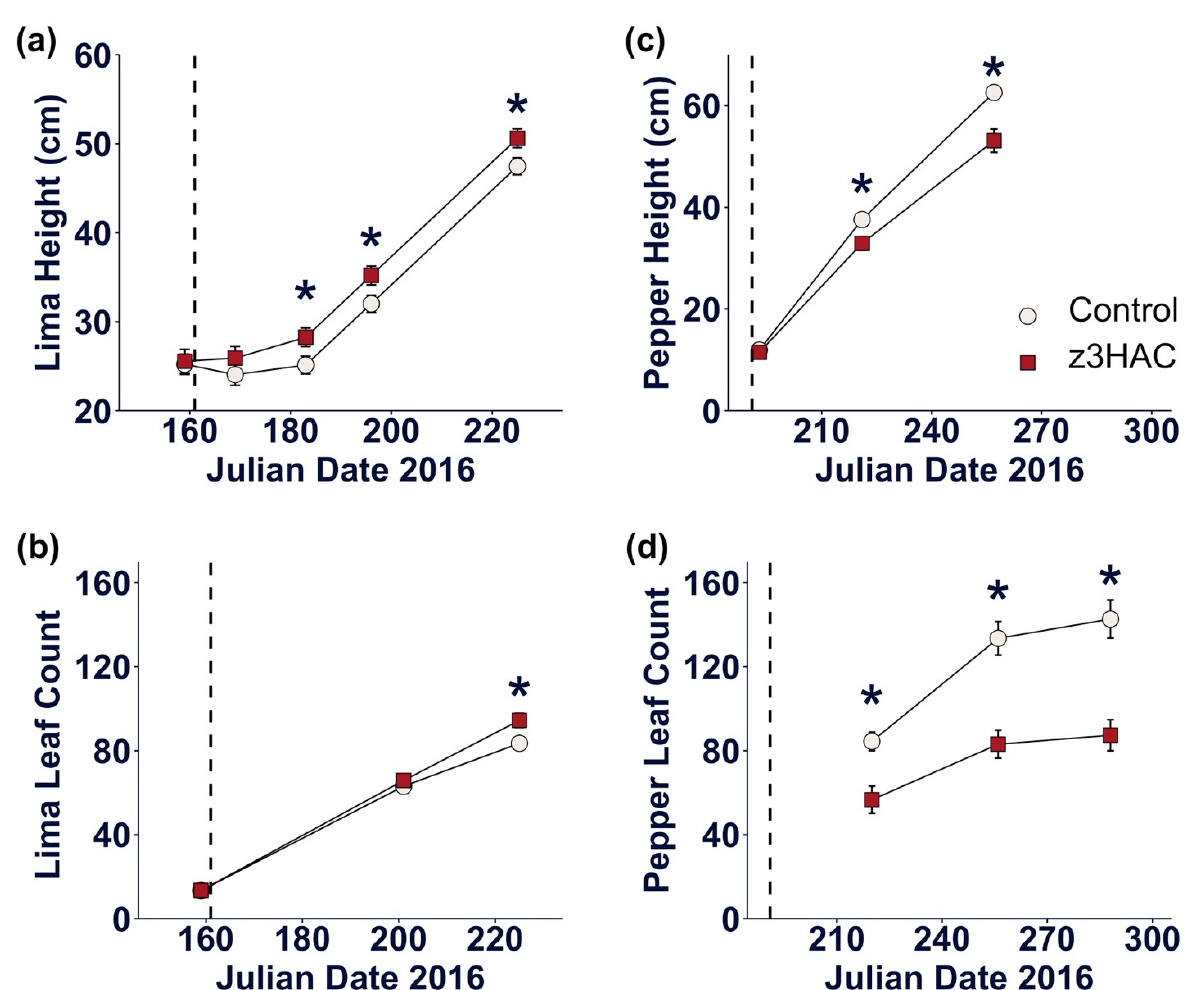
Figure 2. Height measurements and leaf counts for Phaseolus lunatus (lima bean) and Capsicum annuum (pepper) grown in a common garden field experiment. Height for ( a ) lima bean was measured from the base of the longest runner to the uppermost branching point; ( c ) pepper height was measured from the base of the main stalk to the uppermost branching point. Leaf counts for ( b ) lima bean and ( d ) pepper included all mature leaves on each plant. Open circles represent control plants (receiving lanolin-filled vials); filled squares represent plants receiving a persistent application of vials containing 10 ng/hr cis -3-hexenyl acetate ( z 3HAC) dissolved in lanolin. Dropdown lines indicate the initial application of z 3HAC treatment: lima bean and pepper plants were first exposed on 10 June 2016 (Julian date 161) and 11 July 2016 (Julian date 192), respectively. Points represent the averages +/ − SE. Repeated-measures ANOVAs (aov in R) were followed by one-way ANOVAs at each time point. Asterisks (*) represent p < 0.05 between treatment and control at each time point. See Supplemental Table S1 for statistics.